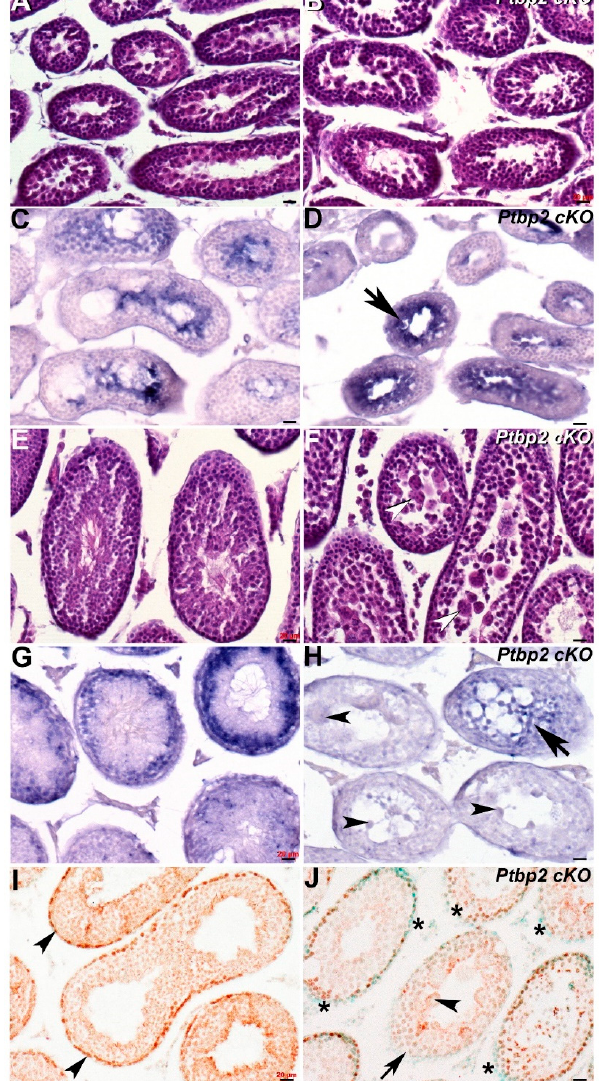
Figure 4. Spatiotemporal analysis of Cracd expression in Ptbp2 cKO testis. ( A , B ) Hematoxylin and eosin staining of P21 wildtype ( A ) and Ptbp2 conditional knockout ( B ) littermate testis. Non- radioactive in situ hybridization detection of Cracd mRNA in P21 wildtype ( C ) and Ptbp2 cKO ( D ) testis, revealing that Cracd expression is more confined and upregulated (arrow, D ). ( E , F ) Hematoxylin and eosin staining of P42 wildtype ( E ) and Ptbp2 conditional knockout ( F ) littermate testis. Note smaller tubule size and multiple giant multinucleated cells evident (arrowheads, F ). Non- radioactive in situ hybridization detection of Cracd mRNA in P42 wildtype ( G ) and Ptbp2 cKO ( H ) testis, revealing Cracd expression is significantly diminished (arrow, H ) and Cracd is not expressed in multiple giant multinucleated cells (arrowheads, H ). ( I , L ) Immunostaining using monoclonal β - catenin antibody (signal is brown DAB precipitate) counterstained with methyl green showed β - catenin expression in P42 wildtype ( I ) and Ptbp2 cKO ( J ) testis sections. Note uniform nuclear localization in peripheral cells in wildtype ( I , arrowheads) but most Ptbp2 cKO seminiferous tubule peripheral cells exhibit reduced β -catenin expression ( J ,*). Moreover, the Ptbp 2 cKO tubule with multiple giant multinucleated cells (arrowheads, J ) is absent of β -catenin expression (arrowhead, J ). Scale bars = all 20 μ